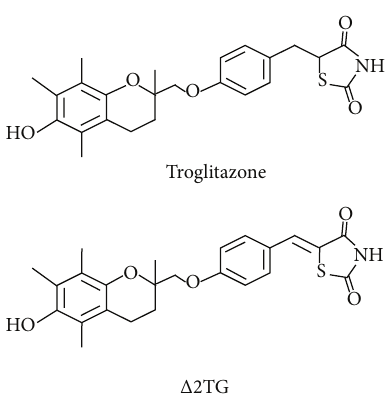
Figure 1: Chemical structures of troglitazone and its PPAR 𝛾 - inactive analogues Δ 2troglitazone ( Δ 2TG). The introduction of the double bond adjoining the terminal thiazolidinedione ring results in the abrogation of the PPAR 𝛾 ligand property of Δ